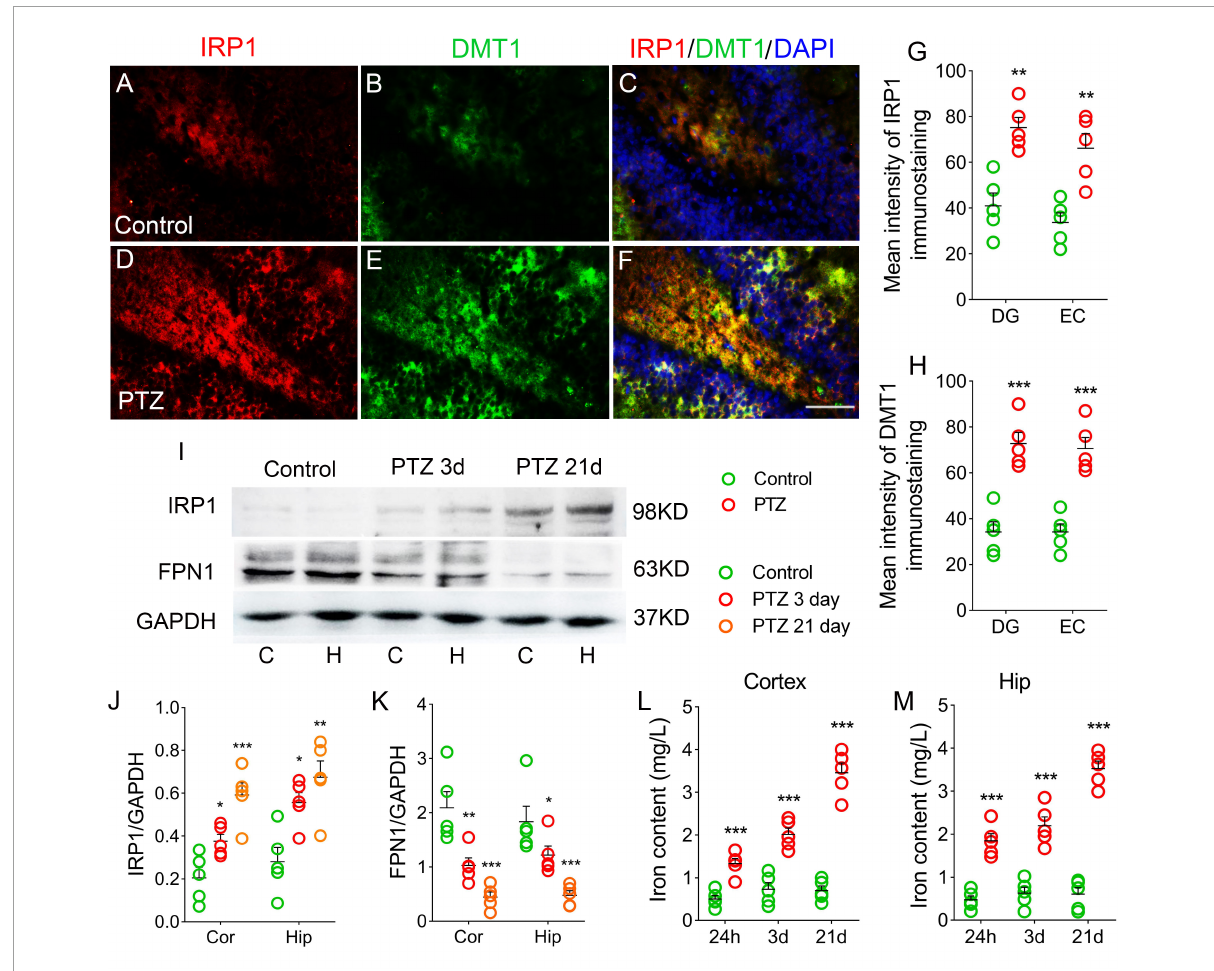
FIGURE2 Pentylenetetrazole (PTZ) significantly increased iron levels. (A–F) Increased fluorescence intensity of IRP1 (red) and DMT1 (green) in the dentate gyrus (DG) region during PTZ-induced epileptogenesis (blue, DAPI). Bar = 80 µ m. (G,H) Quantified changes in IRP1 and DMT1 ( n = 5/group). (I) Expression of IRP1 and FPN1 in the hippocampus and cortex estimated by western blotting ( n = 5/group). (J,K) Normalized intensity of IRP1 and FPN1 relative to GAPDH (one-way ANOVA). (L,M) Levels of iron ( n = 5/timepoint). ** P < 0.01 and *** P < 0.001, compared with controls (unpaired T